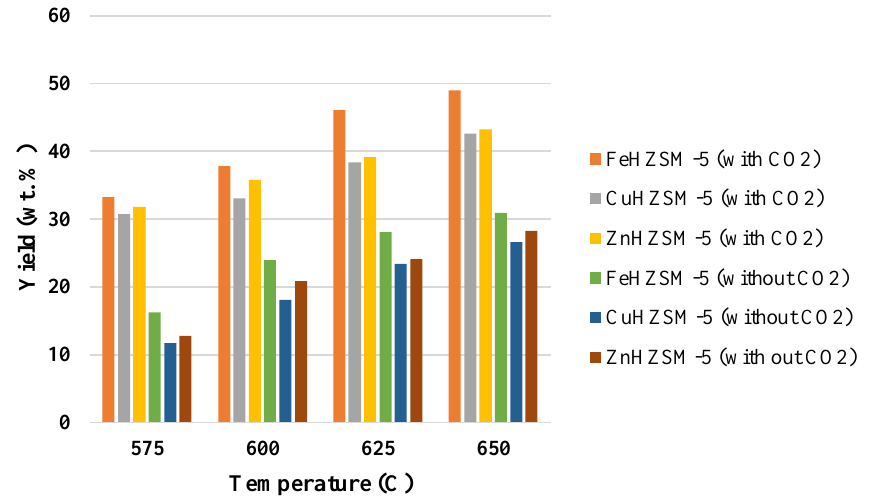
Figure 14. Effect of adding carbon dioxide and temperature on Olefin yield for 4 wt. % FeHZSM-5, 4 wt. % CuHZSM-5 and 4 wt. % ZnHZSM-5 catalysts: 100 mg catalyst, 6 mA, 10 mm gap distance and 4 wt. % metal loading.